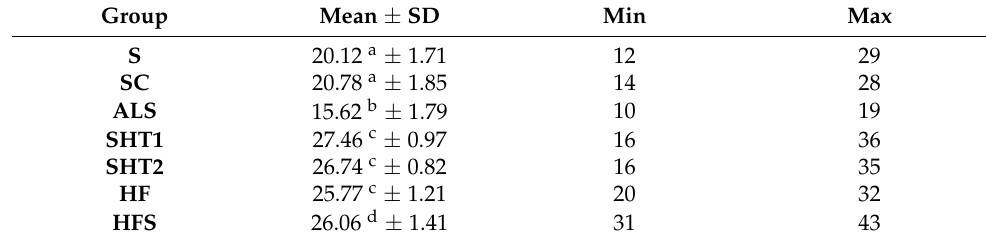
Table 2. Mean, minimum, maximum bond strength values and standard deviations of groups.